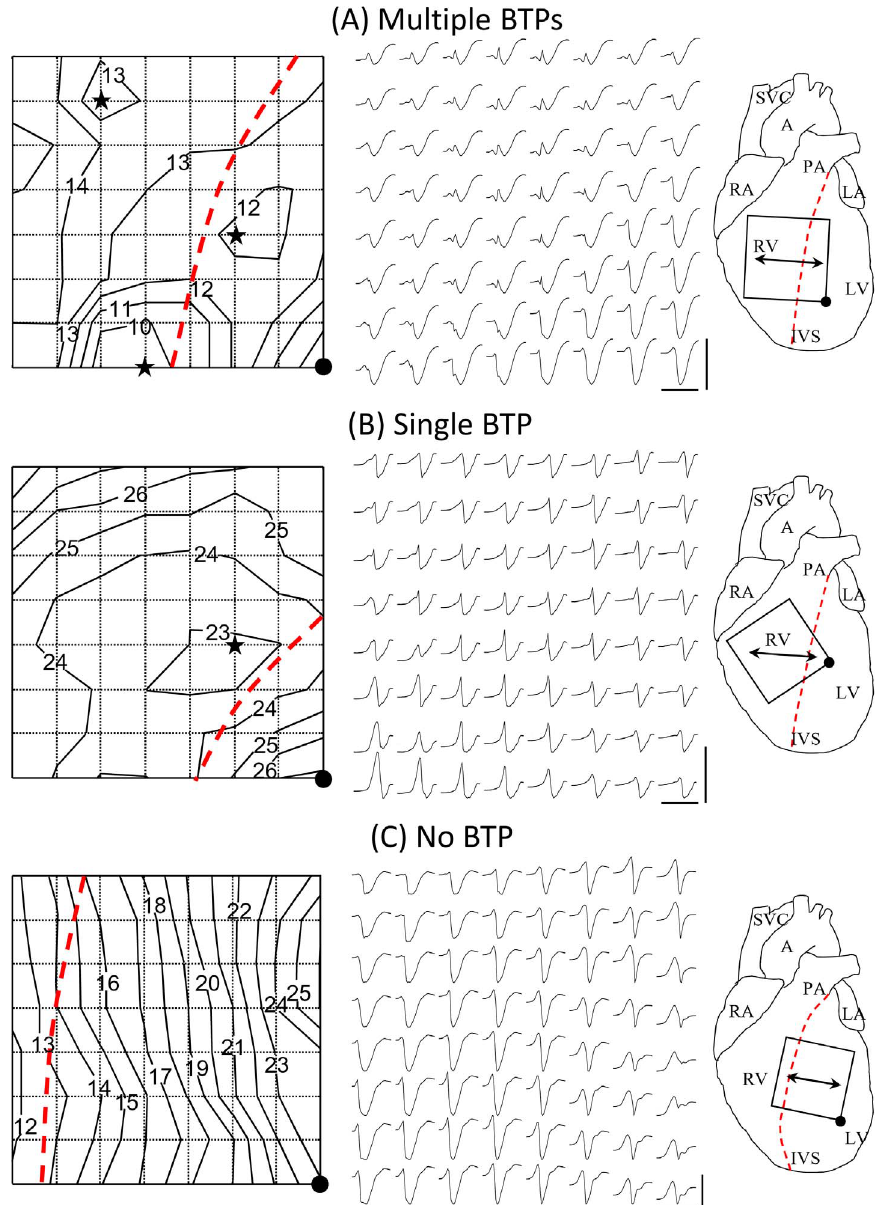
Figure 5. Sinus rhythm ventricular activations recorded in aged rats after the 6 th month. A: multiple breakthrough points (BTPs). B: single BTP. C: absence of BTP. Left panels : activation isochrone line maps. Numbers: activation times in ms from QRS onset; star: BTP site; dotted line, interventricular septum (IVS); black dot on the lower-right corner, reference point for epicardial orientation. Middle panels : 8 6 8 electrode array electrograms (EGs); vertical bar, maximum peak-to-peak EG amplitude (25 mV); horizontal bar, EG time scale (30 ms). Right panels : schematic view of the heart and epicardial electrode array position and orientation. PA, pulmonary artery; A, aorta; SVC, superior vena cava; RA, right atrial appendage; LA, left atrial appendage; RV, right ventricle; LV, left ventricle; dotted line, IVS; double arrowhead, epicardial fiber direction; square box, 8 6 8 electrode array with black dot for epicardial orientation (see above).